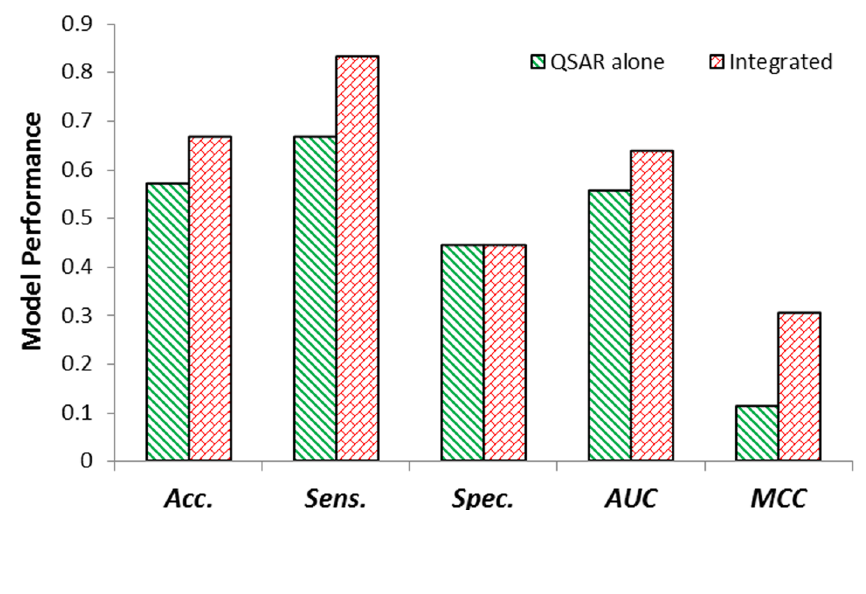
Figure 3. The performance of models on test